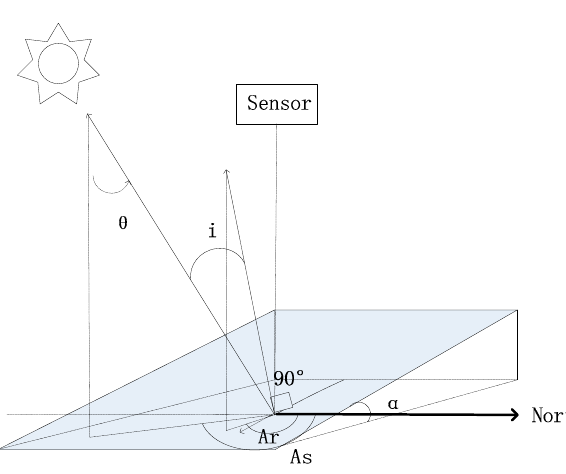
Figure 1. Geometric relationship of "Sun–surface–sensor"